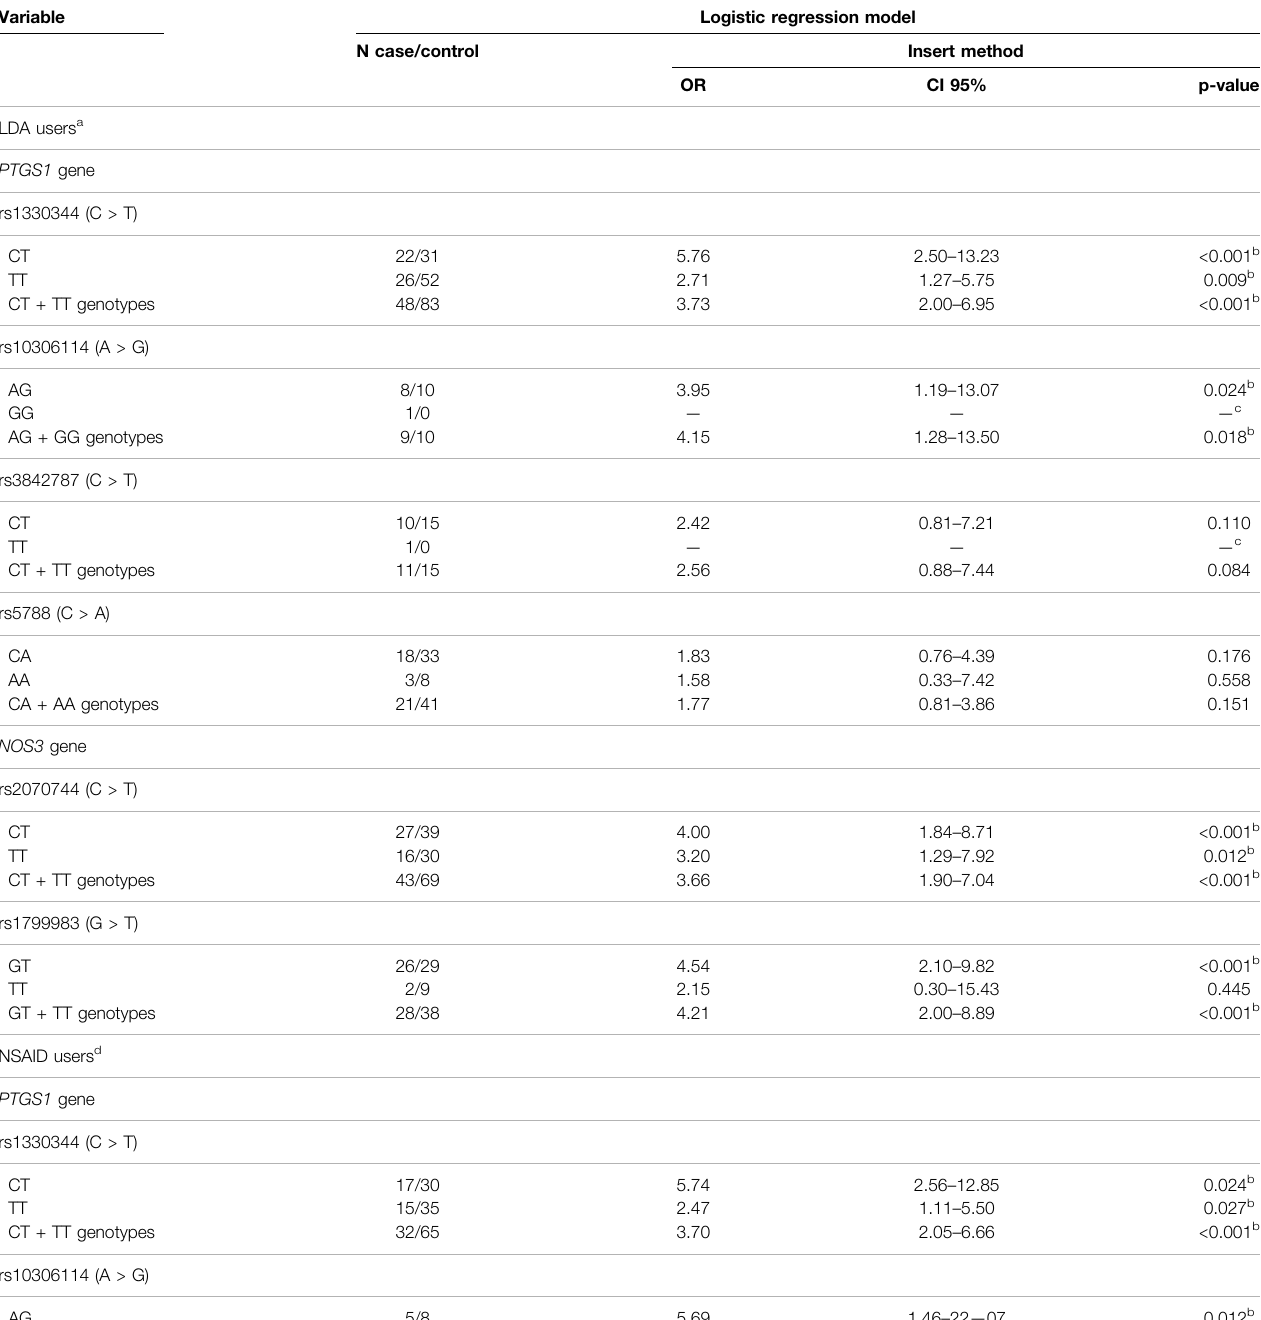
TABLE 4 | Logistic regression model for genetic variants in PTGS1 and NOS3 genes in low-dose aspirin and nonsteroidal anti-in fl ammatory drug users, and risk of upper gastrointestinal bleeding secondary to complicated peptic